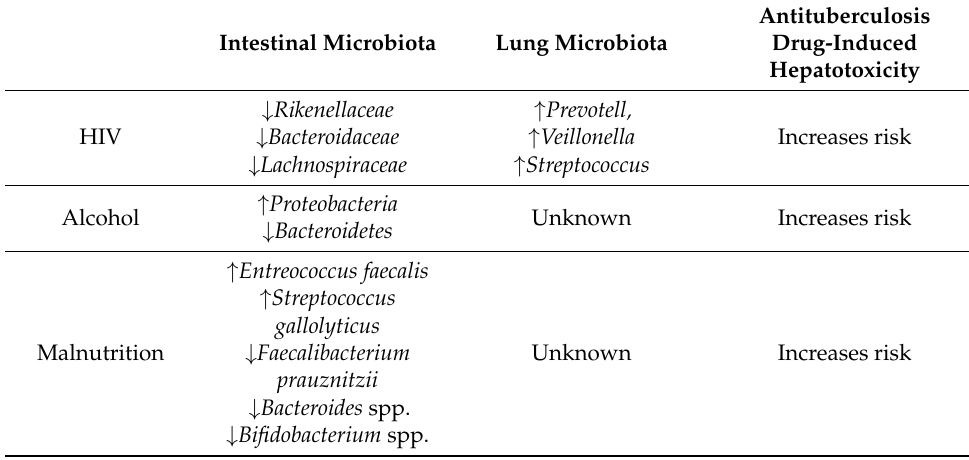
Table 1. Risk factors for tuberculosis known to modulate gut or lung microbiota and hepatic antituberculosis drug metabolism ( modified from reference 67).